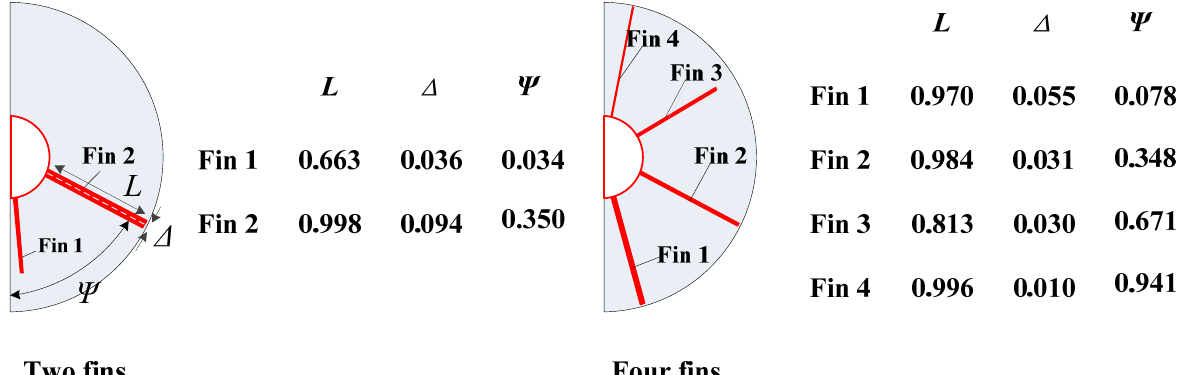
Figure 14. Variation of liquid fraction, f , with the dimensionless melting time, Fo , for Optimal Case 7 and Special Case 5.